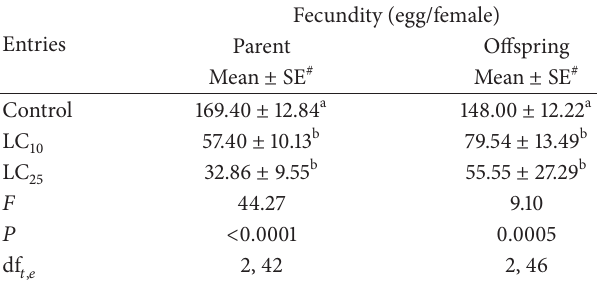
Table 2: Comparison of fecundity of P. xylostella treated with sublethal doses of pyriproxyfen and control (untreated group) in the parent and offspring ( 𝐹 1 generation).